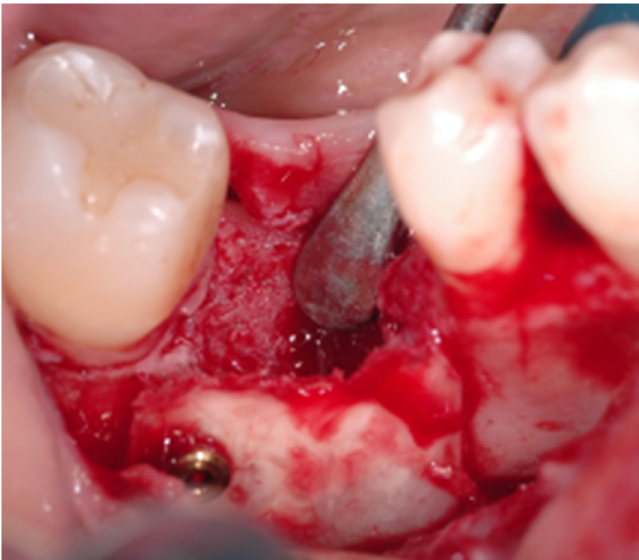
Figure 1. Creation of the containing “box” using a heterologous cortical lamina.